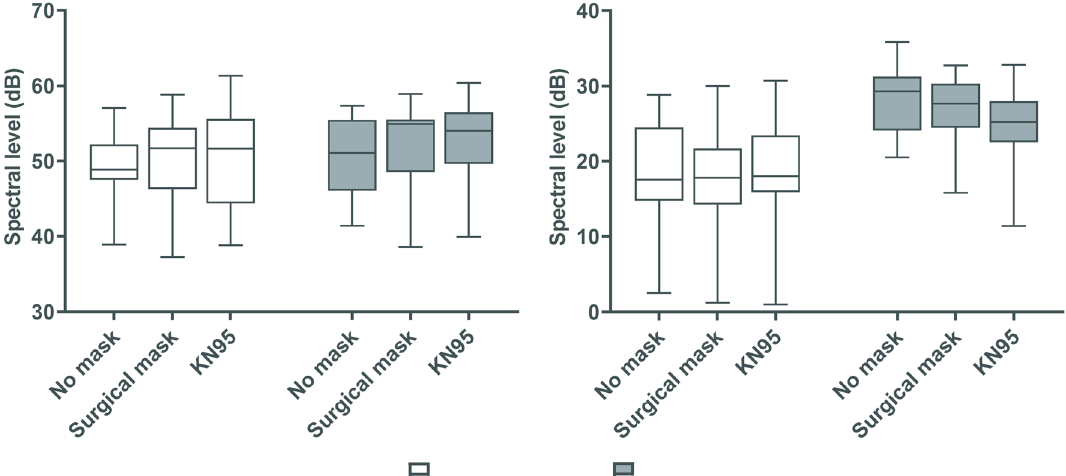
Figure 2. Mean spectral levels at low and high frequency regions across conditions. As sound pressure level was not calibrated, spectral levels were normalized so that the lowest value equalled zero. RP23 = The 2nd and 3rd sentences of the Rainbow Passage.